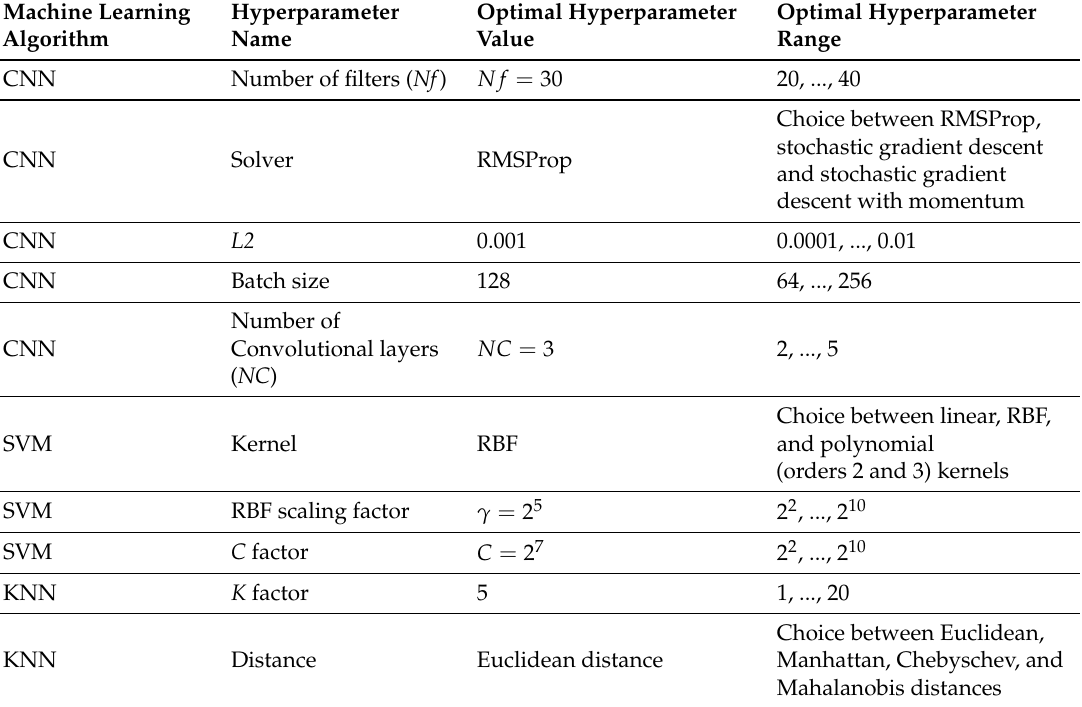
Table 3. Hyperparameters values and ranges of the adopted machine learning